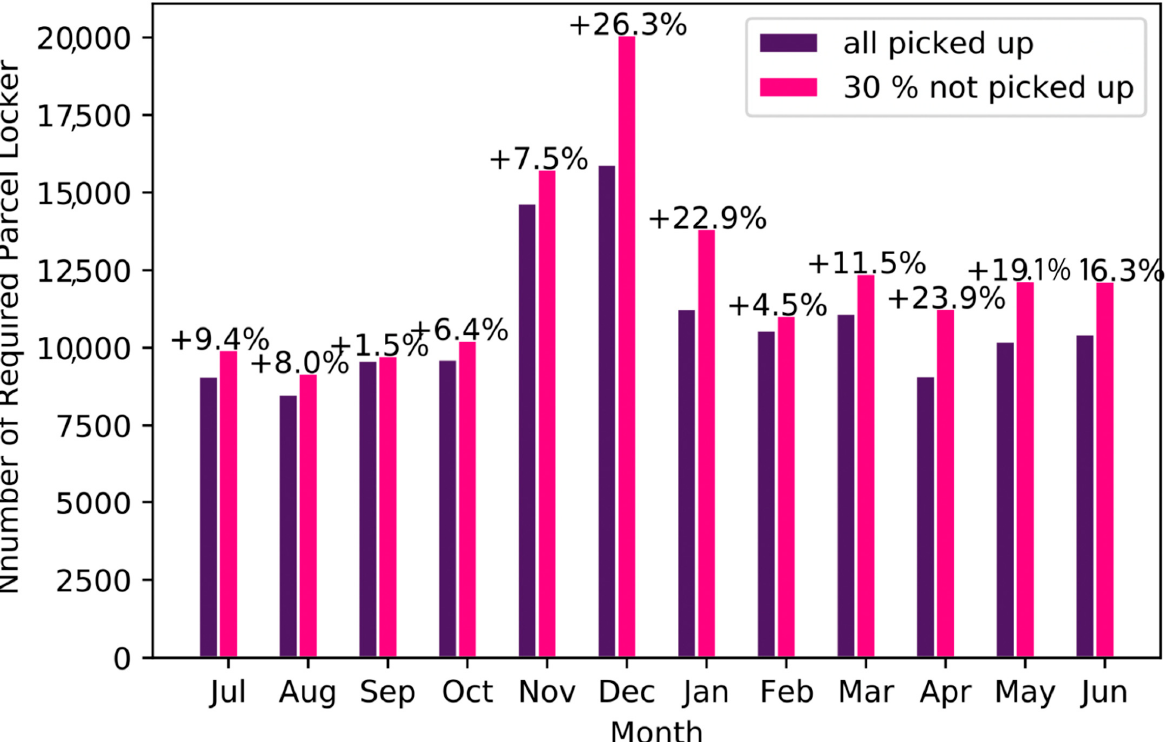
Figure 4. Comparison of the maximum number of locker spaces per month between all parcels picked up and 30% of parcels not picked up (Density 1.0).